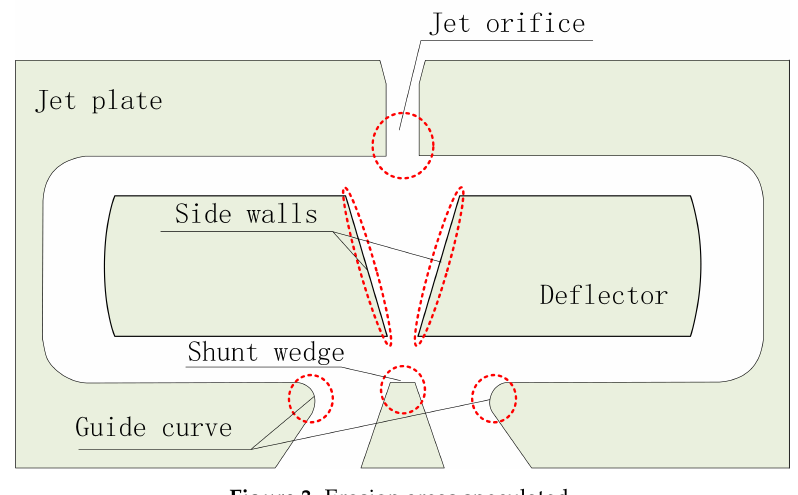
Figure 3. Erosion areas speculated. Table 1. Optimized results of the circular arch for different slenderness and opening angles